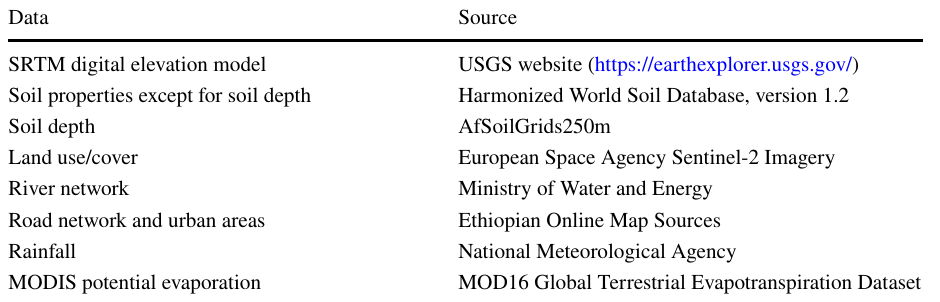
Table 1 Data and their